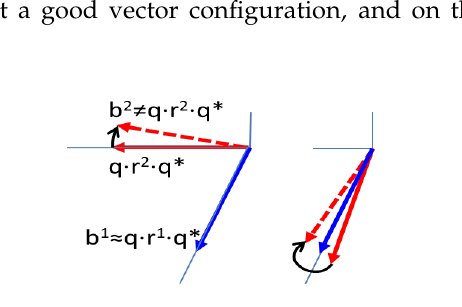
Figure 5. Top plot shows determined (dots) and estimated quaternion (solid) in a simulation with noisy observation vectors. Bottom plot shows simulated (dots) and estimated (solid) angular velocity. Notice the accommodation problem of the Kalman filter. Another problem that can be noticed is the accommodation of the Kalman filter. Let us make a small digression on this. An important field where accommodation problems occur is system